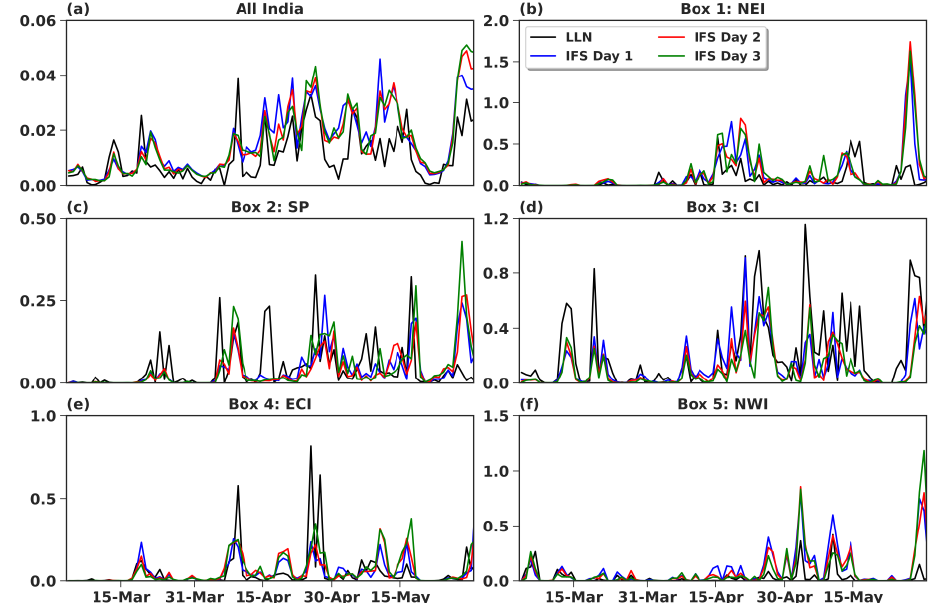
Figure 6. Mean daily time-series of observed and IFS forecast lightning flash density (km − 2 day − 1 ) for MAM 2020 over ( a ) All India, ( b ) Box 1: NEI, ( c ) Box 2: SP, ( d ) Box 3: CI, ( e ) Box 4: ECI, and ( f ) Box 5: NWI.